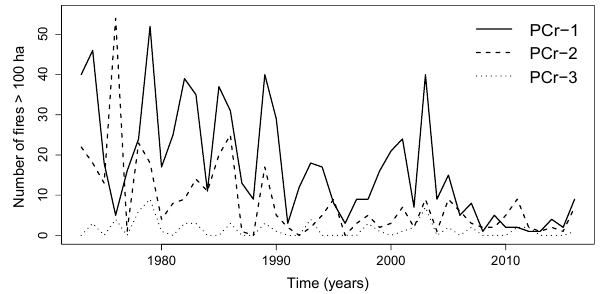
Figure 2. Number of large fires ( > 100ha) for each pyroclimatic region, as a function of